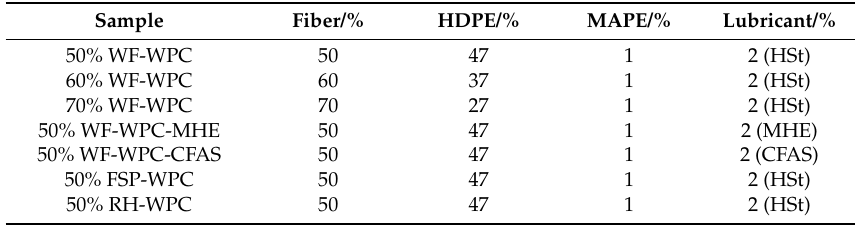
Table 1. The formulation of wood–plastic composites (WPCs) (mass